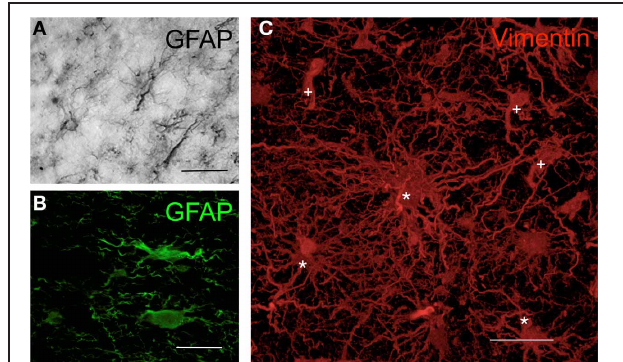
FIGURE 1 | Morphology of human astrocytes by immunohisto- chemistry. (A) Astrocytes in the human cortex visualized by GFAP immunohistochemistry through DAB precipitation in the peritumoral area of a glioma. (B) Astrocytes in human cortex visualized by GFAP immunofluorescence in the peritumoral area of a glioma. (C) Three-dimensional transparency of vimentin + cells in human glioblastoma. Cells in the tumor areas were marked using immunohistochemistry with antibodies against vimentin (red) and were scanned with high-resolution confocal microscopy. Some cells maintain the typical astrocytic star shape ( ∗ ), whereas others show the neoplastic morphology ( + ) that is characteristic of astrocytomas [modified from Carrillo-de Sauvage et al. (2012)]. Scale bar: 30 μ m in (A) and (C) ; 25 μ m in (B)